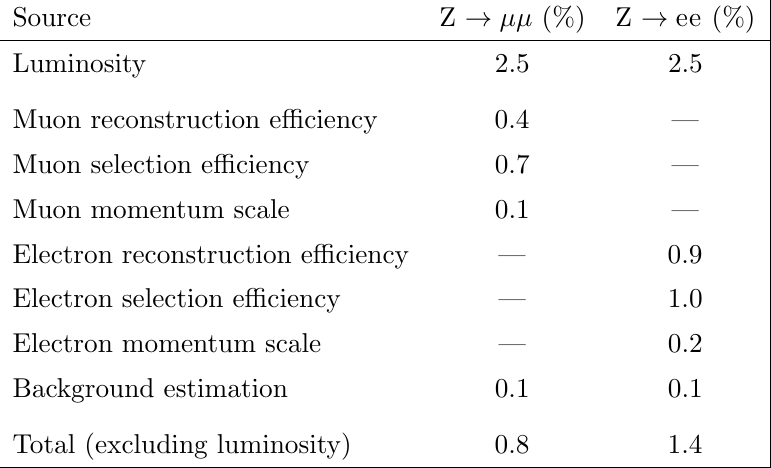
Table 2 . Summary of the systematic uncertainties for the inclusive (cid:12)ducial cross section measure- ments.